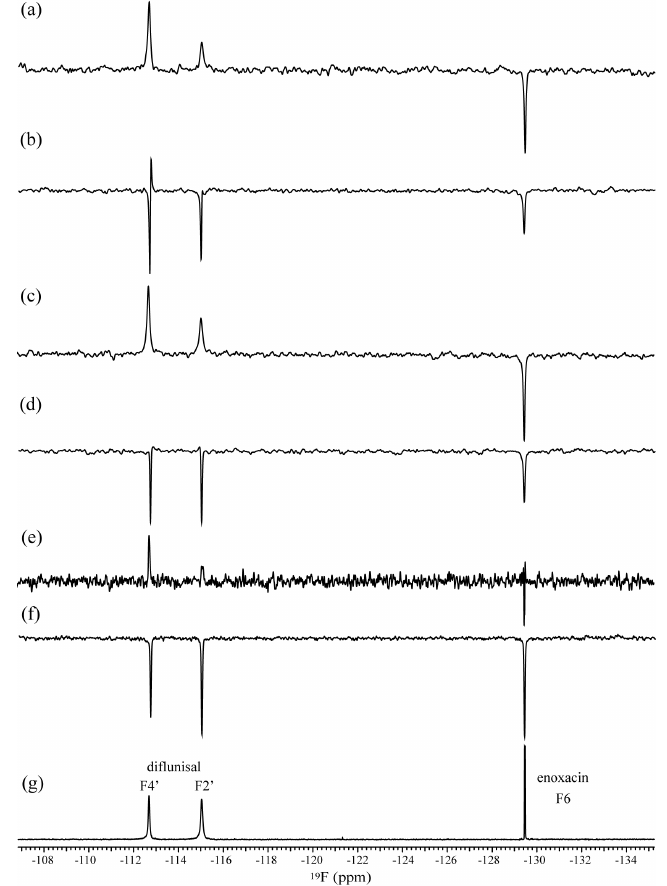
Figure 3. The 19 F-WaterLOGSY spectra acquired using ( a , b ) square-, ( c , d ) Gaussian-shaped pulses, and ( e , f ) a rectangular pulse for the selective water irradiation. In ( a , c , e ), sample (ii); 10 mM diflunisal in the presence of 0.1 mM human serum albumin (HSA) was used, where enoxacin was prepared in a free state. In ( b , d , f ), sample (i); 5.0 mM diflunisal and 5.0 mM enoxacin were used. ( g ) A reference 19 F spectrum of sample (i). The Gaussian, square, and rectangular pulse widths ( γ H1 / 2 π ) were 2.2 ms (565 Hz), 3.3 ms (312 Hz), and 1.0 s (32 Hz), respectively.